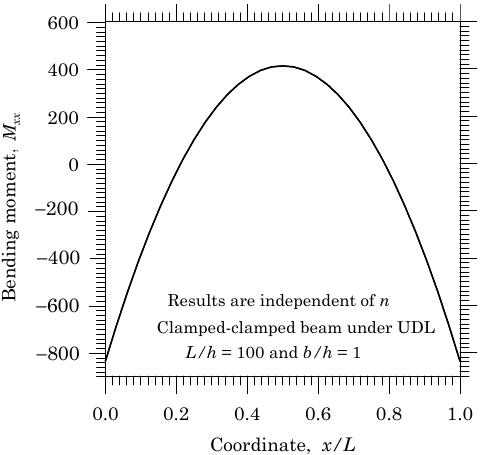
Figure 6. Plots of maximum bending moment M xx ( x ) versus x / L for clamped-clamped FGM beams under uniformly distributed transverse